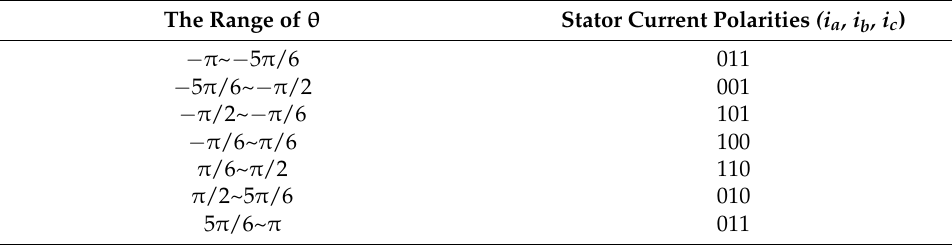
Table 1. Relationship between θ and three-phase stator current